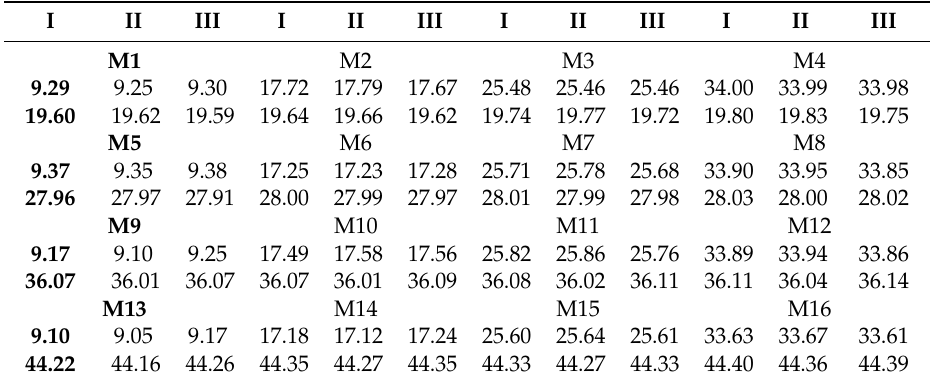
Table 3. Different methods to solve the centroid coordinates of point source target image (unit: pixels).